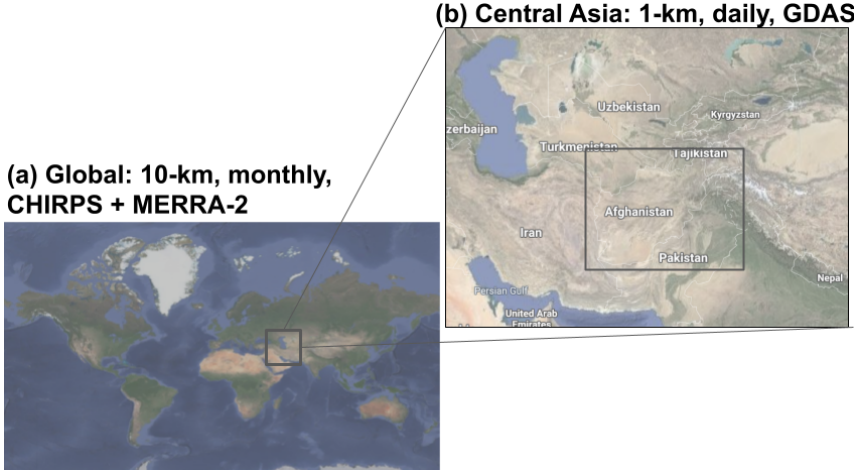
Figure 3. The FEWS NET Land Data Assimilation System (FLDAS) domains for (a) the global data stream at 10km spatial resolution and ∼ 1-month latency for monthly averaged hydrologic estimates and (b) the Central Asia data stream at 1km spatial resolution and ∼ 1d latency for daily averaged hydrologic estimates. Imagery 2021 TerraMetrics, map data ©